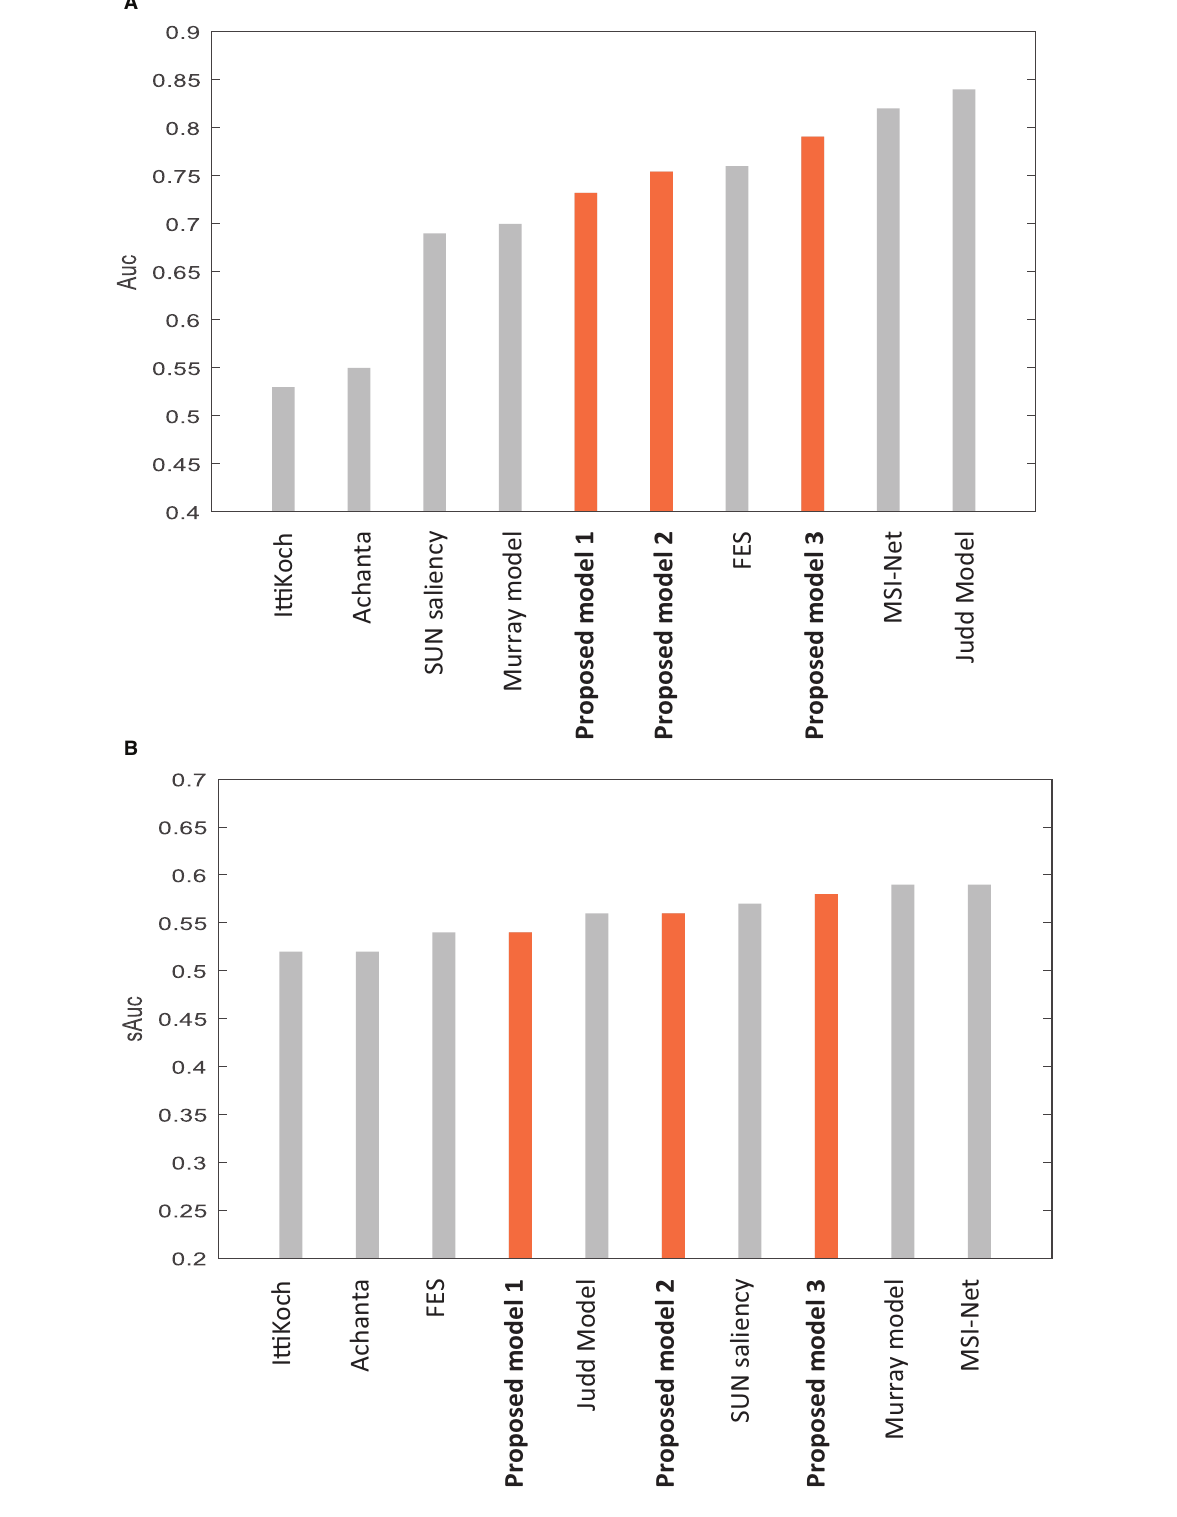
FIGURE4 Comparing the performance of our model to several models evaluated on the CAT2000 dataset based on (A) mean AUC score and (B) mean sAUC score. For more details, refer to the main